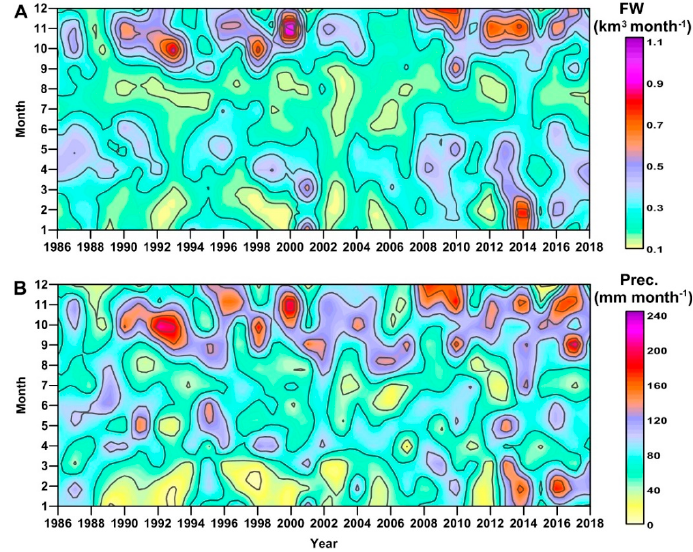
Figure A1. ( A ) Annual cycles of Isonzo River discharge (km 3 month − 1 ) and ( B ) sea surface precipitation in the GoT (mm month − 1 ).